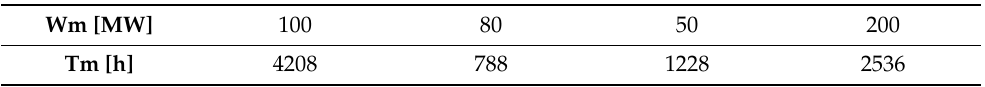
Table 4. Parameters of the cumulative load